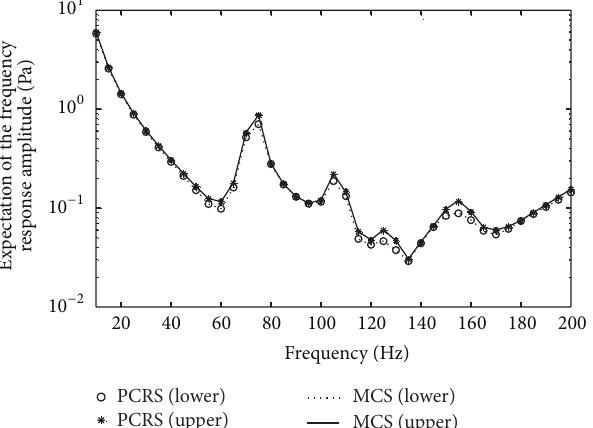
Figure 12: The lower and upper bounds of expectation of the frequency response amplitude at node 𝑅2 calculated by PCRS and MCS in the frequency band 𝑓 = 10 ∼